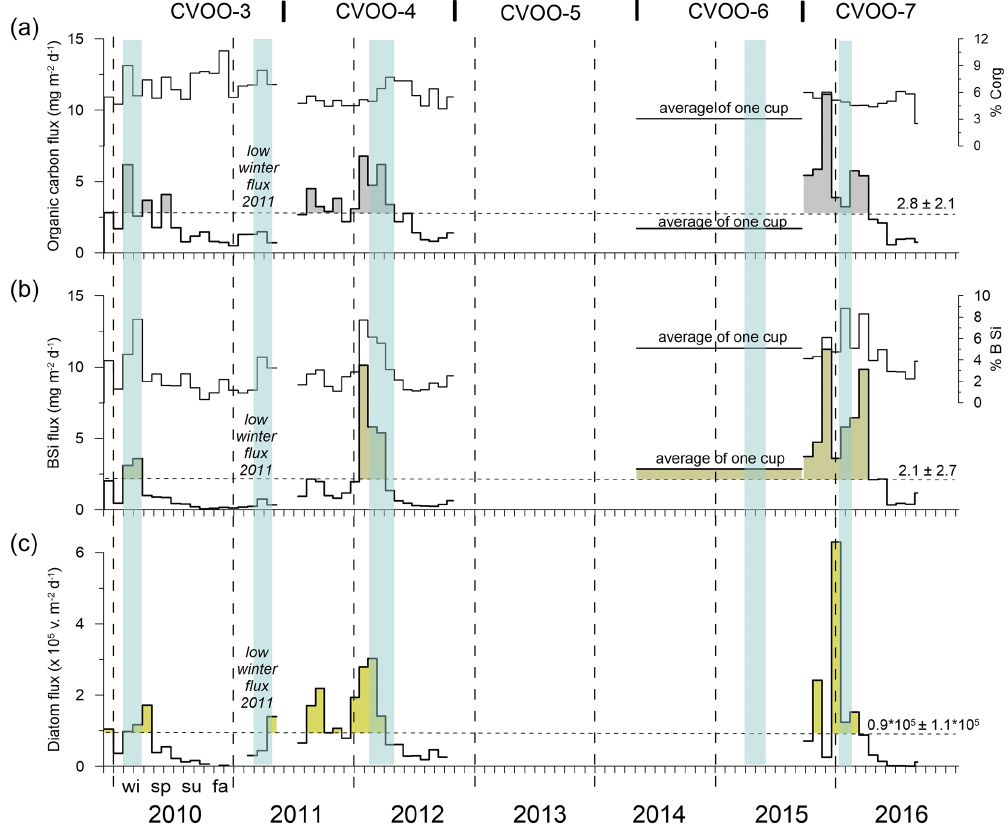
Figure 5. Organic carbon (a) , BSi (b) and diatom fluxes (c) of the upper traps at CVOO. The relative contribution (%) of organic carbon and BSi to the total flux is given as well. Blue bars indicate the passage of low-oxygen/low-salinity eddies in winter with a duration of 1 month and longer (see text). Flux peaks are highlighted (grey, olive and green) when above the mean values (horizontal dashed lines). Note that the peaks of diatom valves (largely composed of small species) only partly match the BSi fluxes. Vertical dashed lines separate years; wi, sp, su and fa indicate seasons. Table 2. Flux relationships with correlation coefficients ( r 2 ) between organic carbon (Corg) and BSi, CaCO 3 and lithogenic material for the winter ACMEs of 2010, 2012 and 2016 and under oligotrophic conditions in 2011. Values at the 99% confidence level are in bold. The case of the structure is estimated from the salinity ( S ) and oxygen (O 2 ) upper-water-column recordings from the CVOO site (Fig. 3). The slopes of the flux relationships from the ACMEs of 2012 and 2016 largely match. ACME denotes anticyclonic mode-water